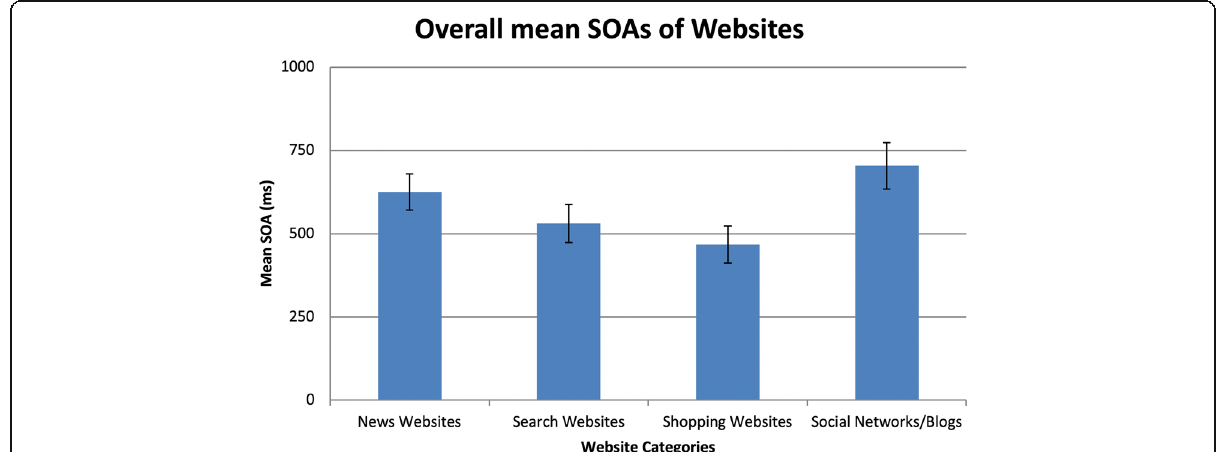
Fig. 6 Mean SOAs across the four categories of websites. Error bars are within-subjects 95% confidence intervals (Cousineau, 2005; Morey,